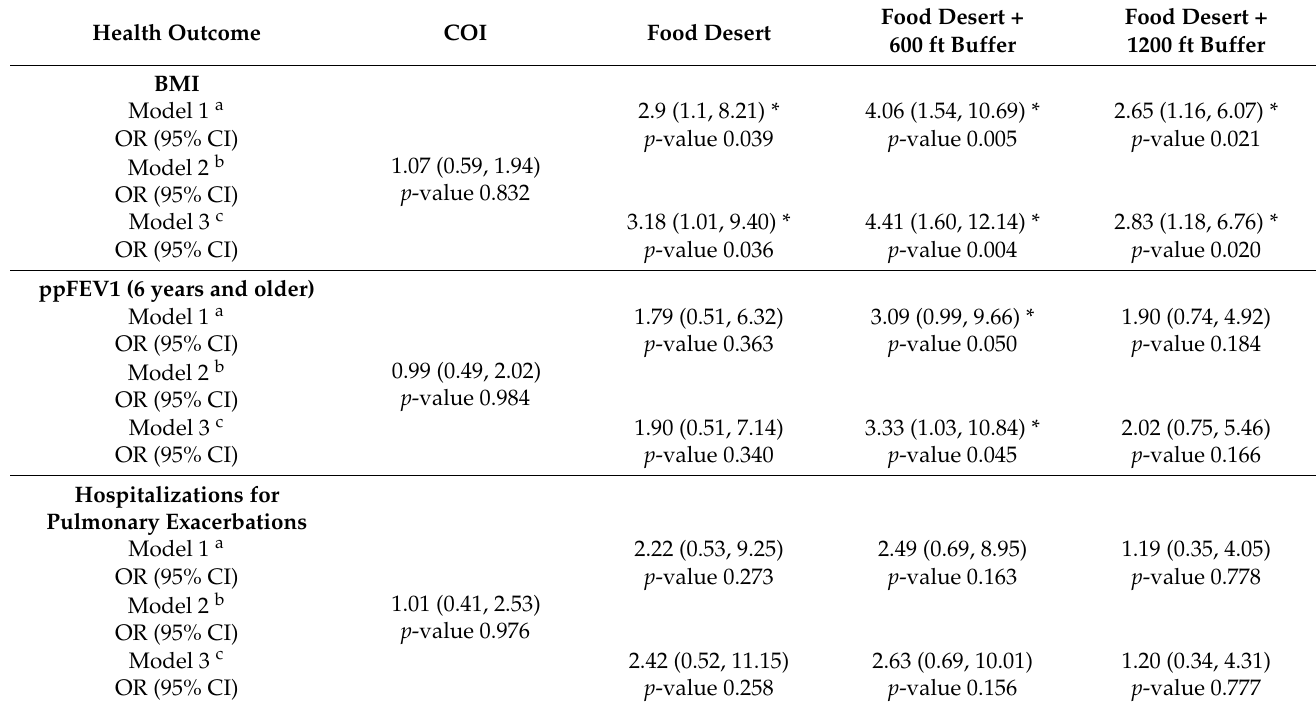
Table 2. Multiple Regression Models of CF Outcomes: Food Deserts, Surrounding Regions, and